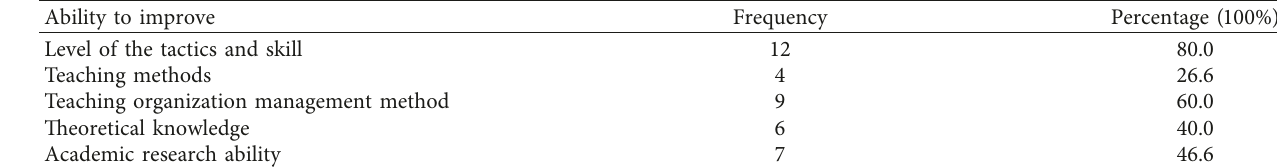
Table 10: Reform the ability of P.E. teachers in pilot colleges who think they need to improve ( n � 15). Ability to improve